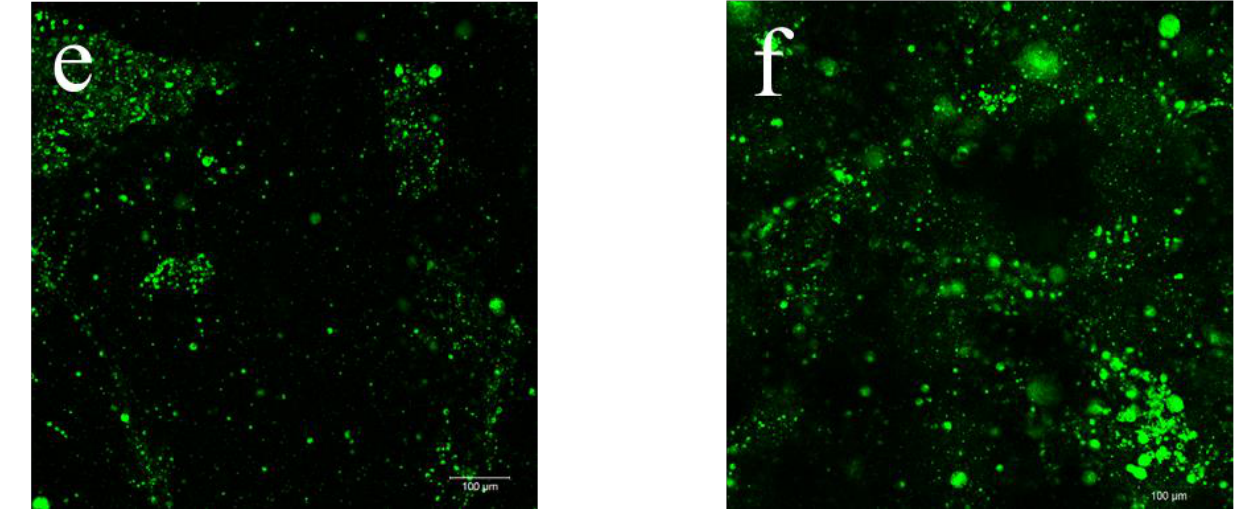
Figure 3. Selected 2D micrographs via CLSM of CS-DES films incorporating 0% ( a ), 0.25% ( b ), 0.5% ( c ), 2% ( d ), 5% ( e ) and 10% ( f ) of açaí PECs at 10× magnification. The encapsulated açaí oil within the PECs appears green while the CS-DES based films appear black.